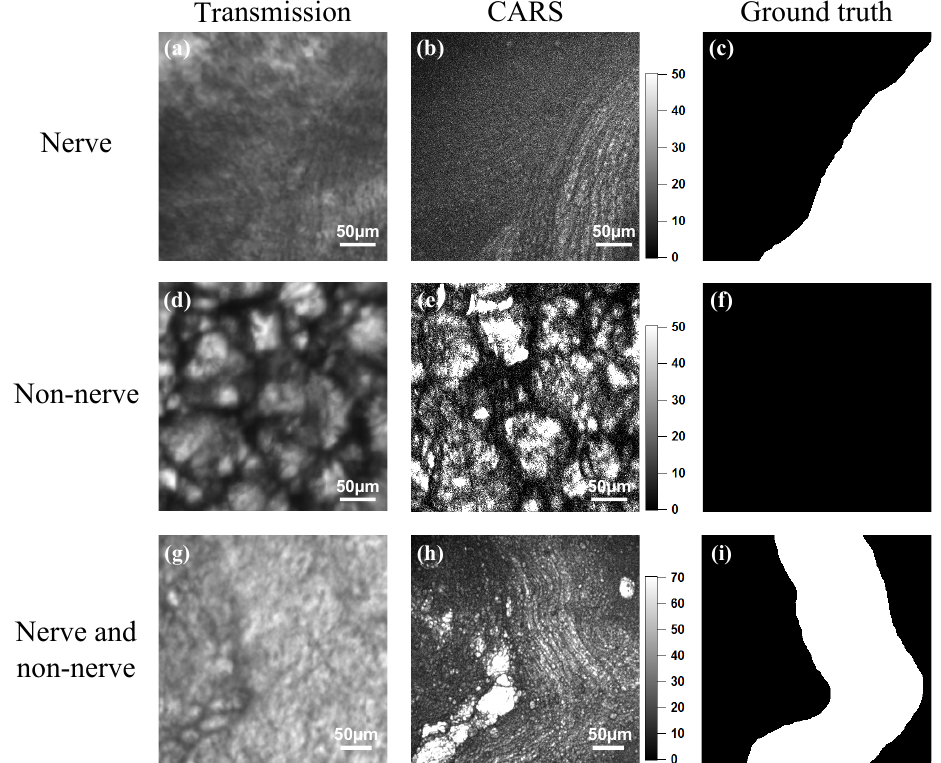
Figure 4. CARS endoscopic imaging of rabbit peri-prostatic fascia. ( a , d , g ) Transmission images. ( b , e , h ) CARS rigid endoscopy images. ( c , f , i ) Ground truth images. ( a – c ) A sample containing